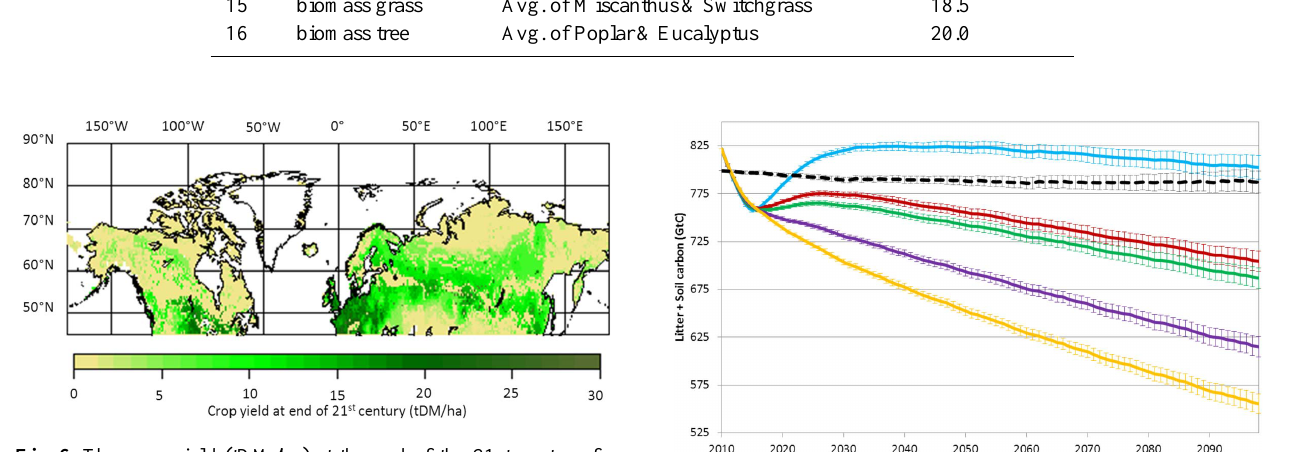
Fig. 6. The crop yield (tDM/ha) at the end of the 21st century for the UNLIM scenario. The values plotted are a mean of the 19 values simulated by LPJmL as a result of using climate data simulated by 19 GCMs (Table 1). Fig. 7. Long-term carbon emissions from the litter and soil carbon